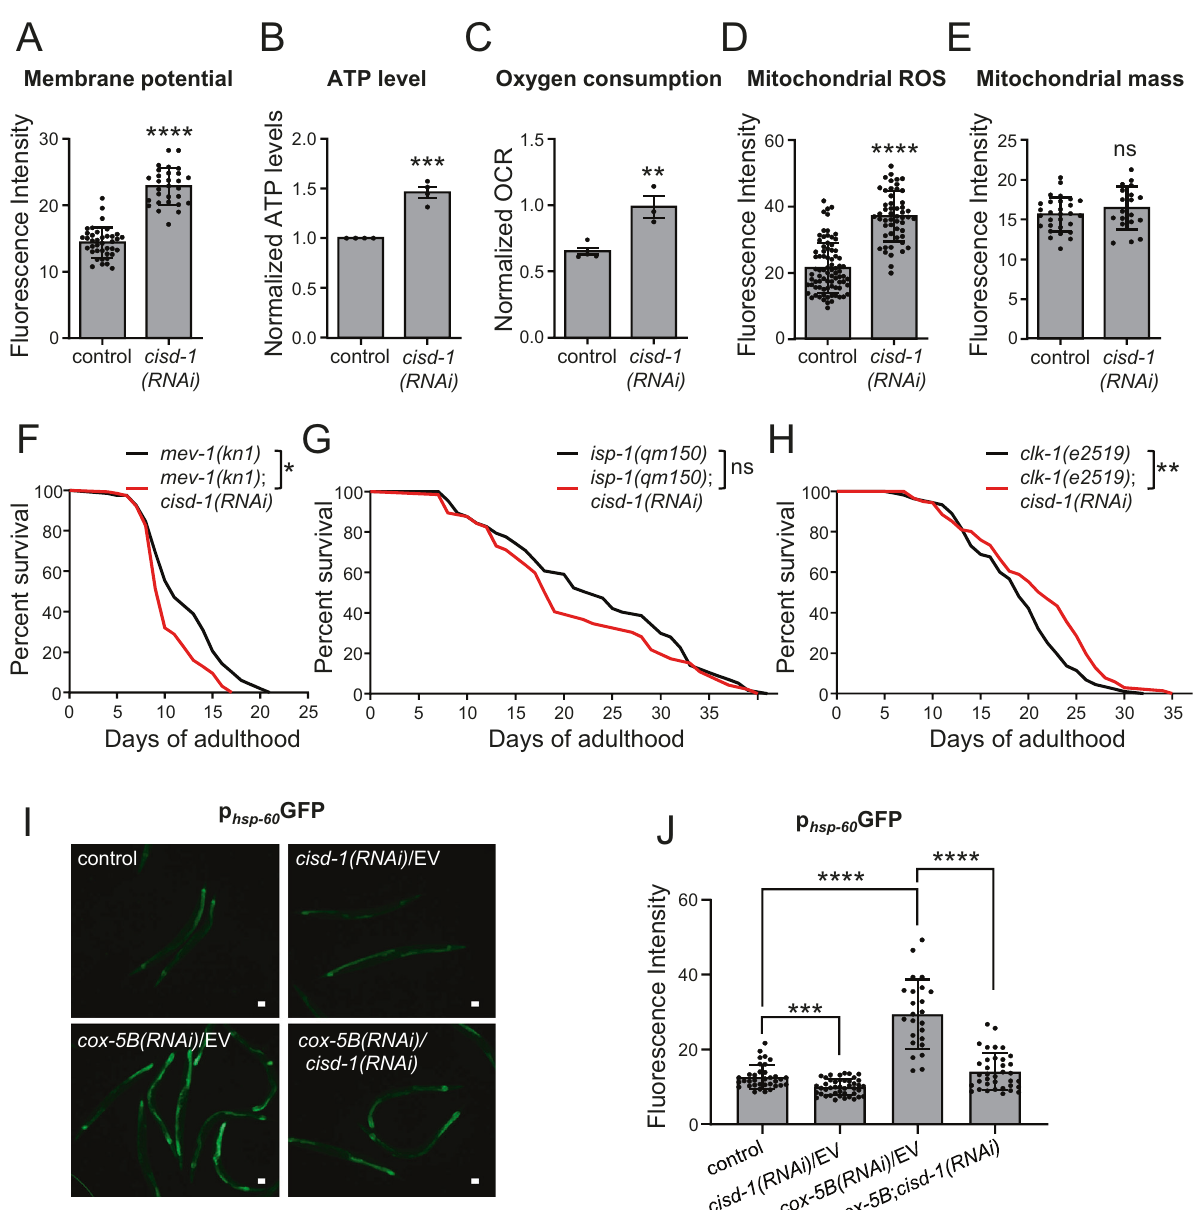
Fig. 2 CISD-1 regulates mitochondrial bioenergetics, and its pro-longevity effects require intact mitochondrial function. A . Membrane potential of day-1 wt (N2) animals, treated with either empty vector (control) or cisd-1(RNAi) and supplemented overnight with the selective mitochondrial dye TMRE. Values represent mean ± SD ( n = 30; **** P < 0.0001, unpaired t-test). B ATP levels were determined in day-1 wt (N2) animals treated with either empty vector (control) or cisd-1(RNAi) . The graph summarizes the results of four independent experiments and ATP levels are shown relative to control samples (wt animals treated with empty vector). Values represent mean ± SEM (*** P < 0.001, unpaired t- test). C Oxygen consumption rate (OCR) was determined in day-1 wt (N2) animals, treated with either empty vector (control) or cisd-1(RNAi) . One representative experiment is shown, with four technical replicates per condition. OCR was normalized to total protein levels. Values represent mean ± SD (** P < 0.01, unpaired t-test). D For the determination of mitochondrial ROS, mean fl uorescence intensity was measured in day-1 wt (N2) animals treated either with empty vector (control) or cisd-1(RNAi) . L4-staged animals were supplemented overnight with the selective mitochondrial dye MitoTracker ™ Red CM-H 2 Xros. Values represent mean ± SD ( n = 50; **** P < 0.0001, unpaired t-test). E Mitochondrial mass of day-1 adult nematodes of the SJ4143 [p ges-1 mtGFP] strain, treated with either empty vector (control) or cisd- 1(RNAi) . Values represent mean ± SD ( n = 25; ns P > 0.05, unpaired t-test). F Survival curves of mev-1(kn1) animals treated with empty vector (black line) or cisd-1(RNAi) (red line) from hatching (* P < 0.05, Log-rank/Mantel – Cox test). G Survival curves of isp-1(qm150) animals treated with empty vector (black line) or cisd-1(RNAi) (red line) from hatching (ns, P > 0.05, Log-rank/Mantel – Cox test). H Survival curves of clk-1(e2519) animals treated with empty vector (black line) or cisd-1(RNAi) (red line) from hatching (** P < 0.01, Log-rank/Mantel – Cox test). I. Representative images of day-2 animals of the UPR mt reporter strain SJ4058 [p hsp-60 GFP], treated with empty vector (control), cisd-1(RNAi) (diluted with empty vector), cox-5B(RNAi) (diluted with empty vector) and double RNAi for cisd-1 and cox-5B . J Quanti fi cation of the mean fl uorescence intensity of RNAi-treated animals of the SJ4058 strain. Values represent mean ± SD ( n = 35; *** P < 0.001, **** P < 0.0001, one-way ANOVA/ Tamhane ’ s T2 multiple comparisons test). Scale bars in all panels are 20 μ